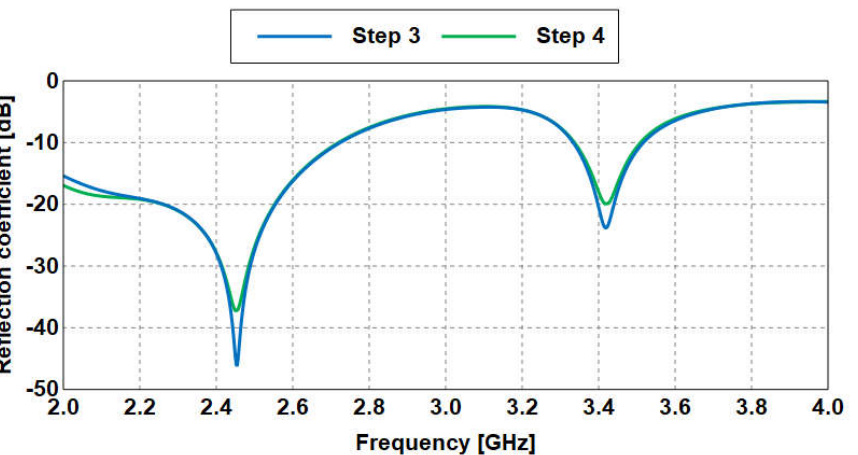
Figure 18. Reflection coefficients of Steps 3 and 4 of the proposed method in designing the dual band slot antenna.